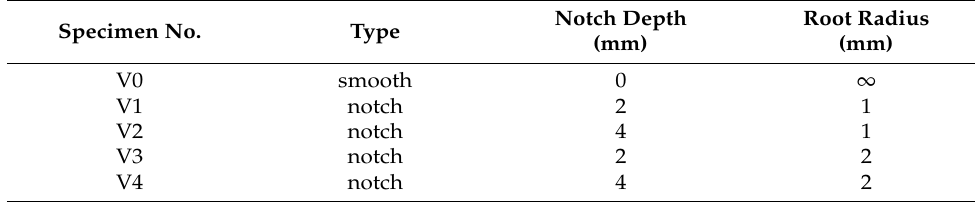
Table 1. Summary of notch depth and root radius of